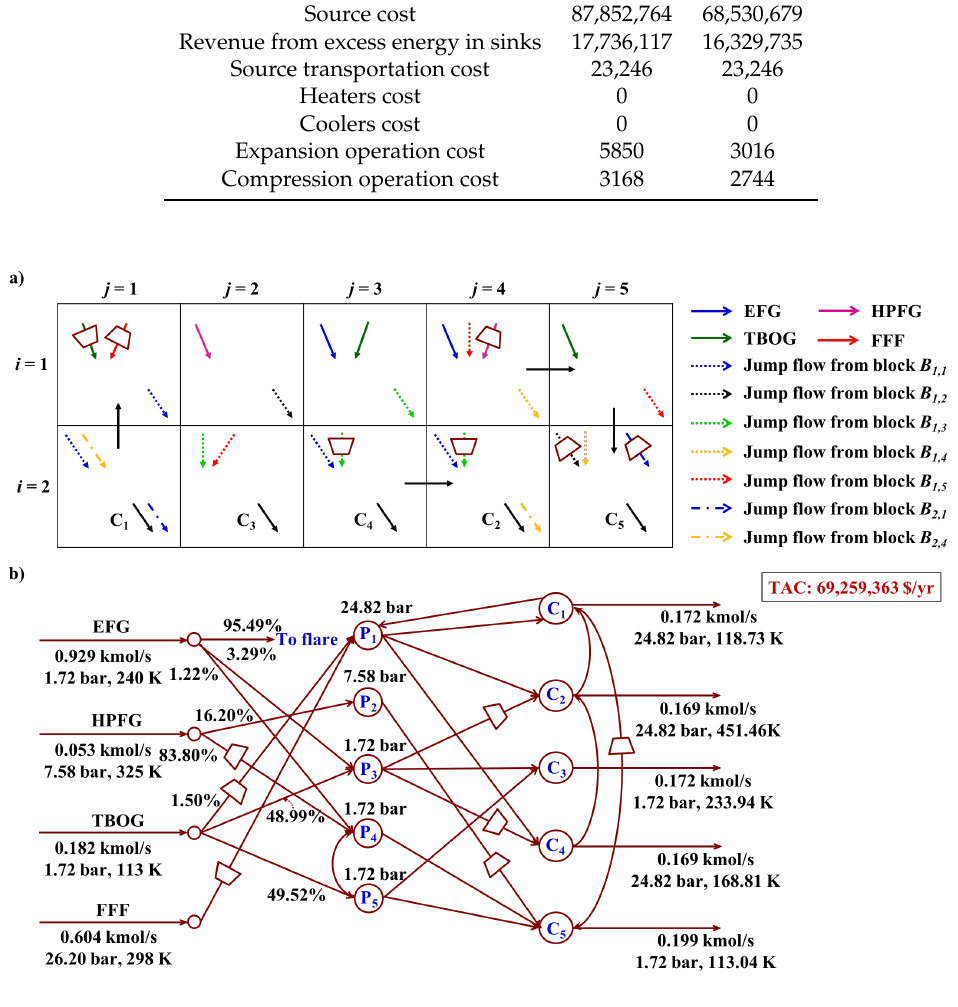
Figure 8. Block representation and process flowsheet for the optimal solution of FGN with intermediate pools: ( a ) Block representation for the optimal solution of FGN; ( b ) process flowsheet for the optimal solution of